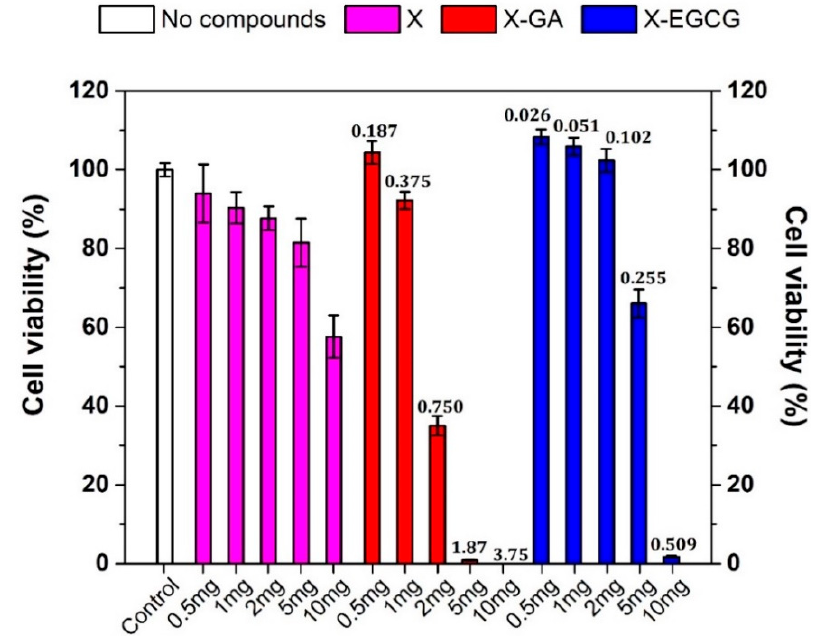
Figure 5. MTS viability bioassay of Caco-2 cells after 24 h incubation with complete growth medium (control, white bar) and increasing amounts of empty xanthan nanofibers (X, magenta bars), gallic acid-loaded xanthan nanofibers (X-GA, red bars), and ( − )-epigallocatechin gallate-loaded xanthan nanofibers (X-EGCG, blue bars). The numbers reported on top of the red and blue bars represent the maximum releasable concentration (mM) of GA and EGCG in a 1.2 mL volume of complete growth medium. Data were the mean ± SD of four independent experiments.